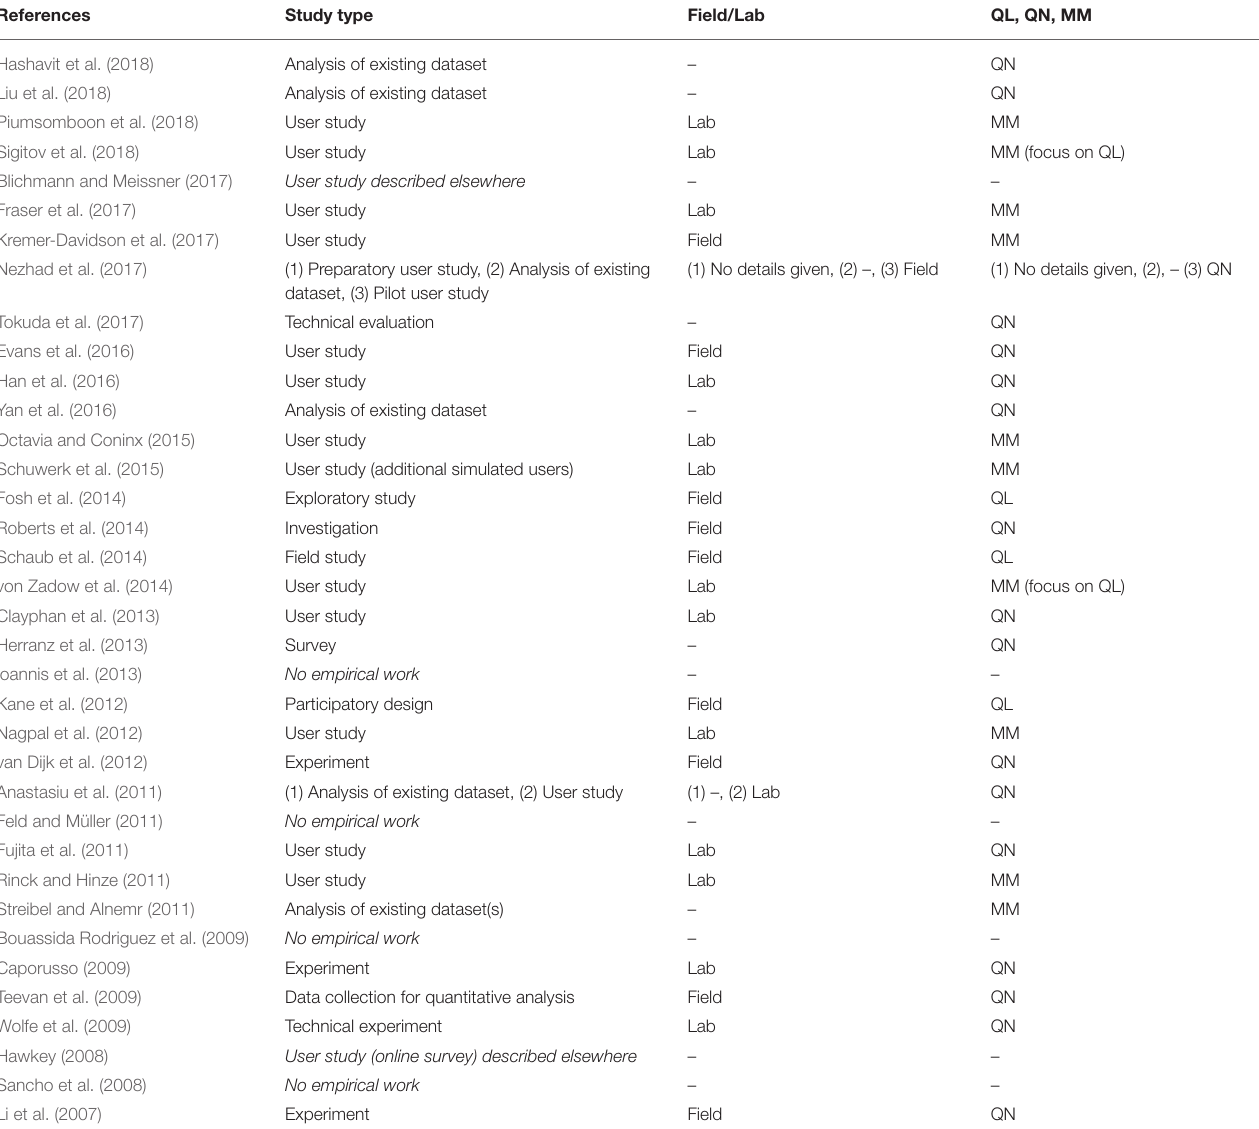
TABLE 3 | Overview of study